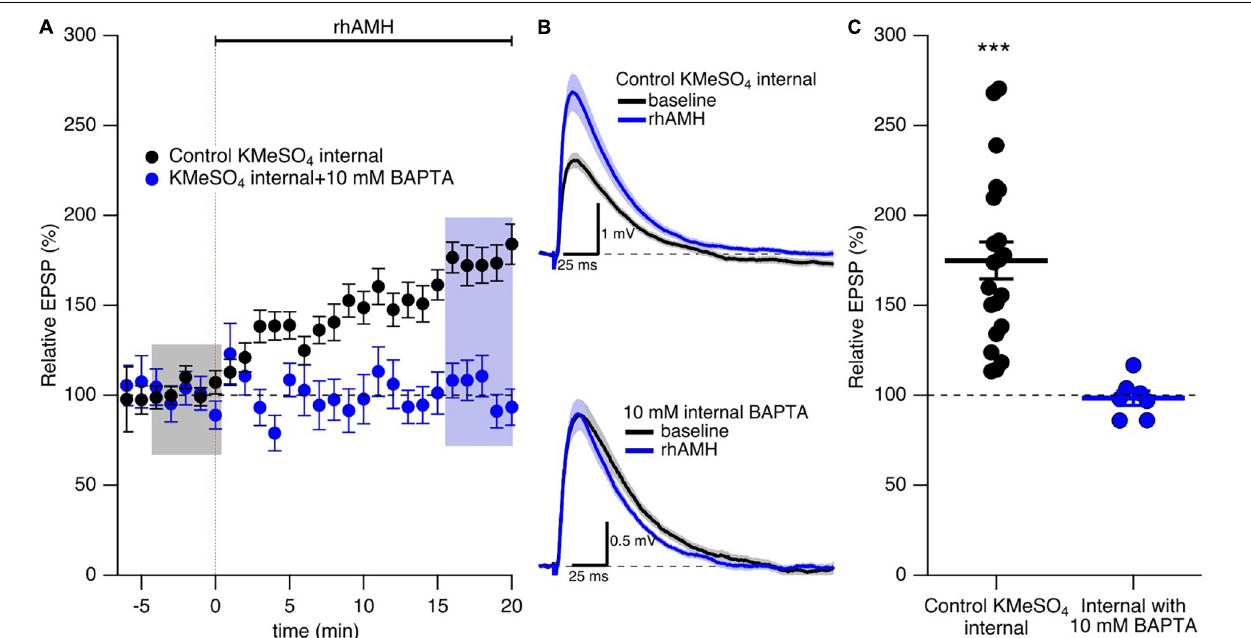
FIGURE 4 | The boosting effect of anti-Müllerian hormone (AMH) requires increased intracellular Ca 2 + mobilization. (A) Summary time course plots of evoked EPSP amplitudes with bath application of 0.4 nM rhAMH at 0–20 min in control KMeSO 4 internal solution (black symbols) and KMeSO 4 internal containing 10 mM BAPTA (blue symbols). rhAMH addition increased EPSPs in control internal ( p < 0.0001) but did not increase EPSPs when intracellular Ca 2 + was chelated by 10 mM BAPTA ( p = 0.44). Data are binned into 1 min intervals, mean ± SEM. (B) Representative current traces (average of 15 EPSPs) were acquired in the control solution (baseline, black) and in the presence of rhAMH (blue) for individual neurons in control KMeSO 4 internal (upper panel) and 10 mM BAPTA containing KMeSO 4 internal (lower panel). (C) Summary scatterplot of normalized EPSP amplitude. Bars represent mean ± SEM. *** p < 0.0001.